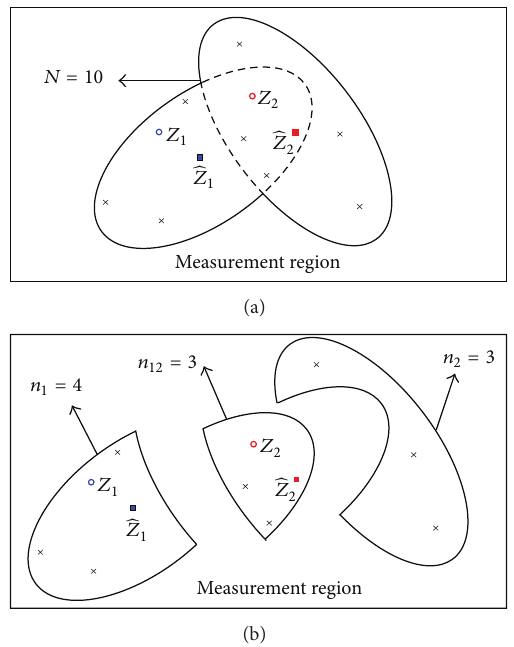
Figure 2: Regulations of measurement validation regions, (a) as a union, (b) in separated